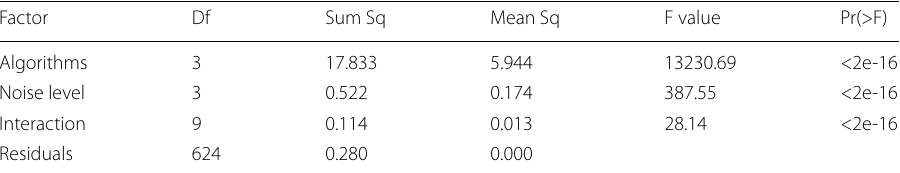
Table 4 Two-factor ANOVA for FNR